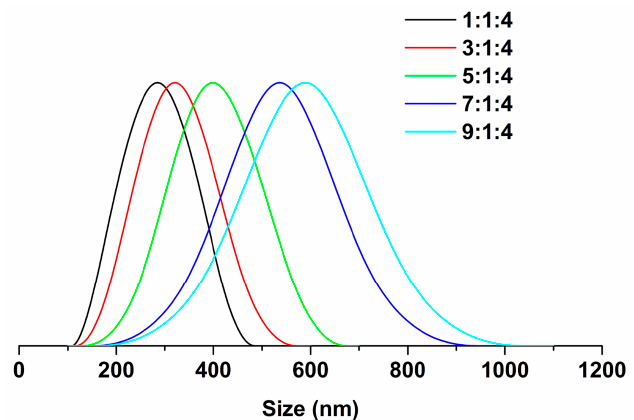
Figure 6. Size distribution of SG-Ag/PAN electrospun fibers prepared with different feed ratios of PAN and SG to Ag NPs: 1:1:4, 3:1:4, 5:1:4, 7:1:4, and 9:1:4.